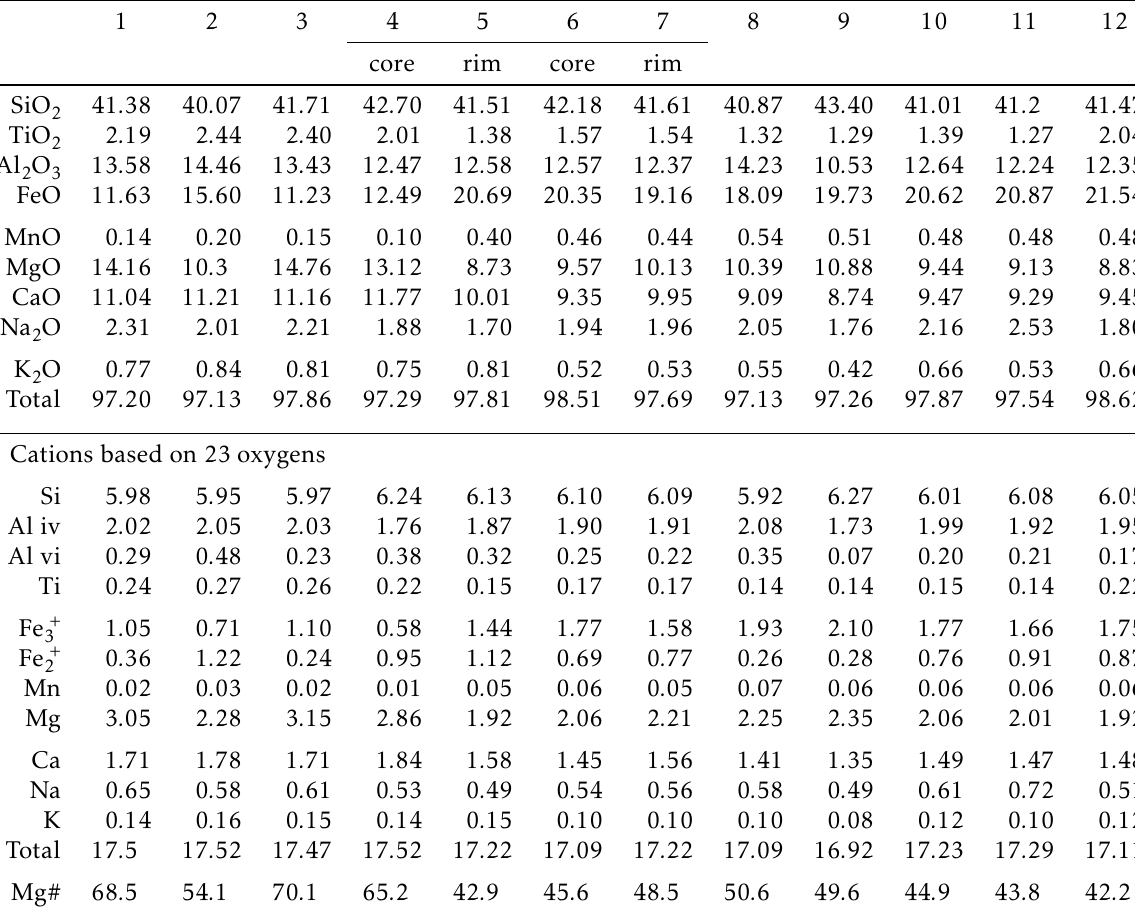
Table 2: Representative major element analyses of amphibole. Cations based on 23 oxygens (apfu). Structural for- mulae calculated with the ProbeAmph spreadsheet [Tindle and Webb 1994]. Comments on occurrence: 1–2: green hornblende phenocrysts; 3: green hornblende from a Hb-Pl clot; 4–5: complex hornblende shown in Figure 4G; 6–7: brown hornblende phenocryst; 8: brown hornblende associated with garnet; 9: brown hornblende in reac- tion rim of a metasedimentary enclave; 10: brown hornblende with Opx inclusion; 11–12: “brown-black” opacitised hornblende phenocrysts. Mg# = 100Mg/(Mg ` Fet) in moles, where Fet is total